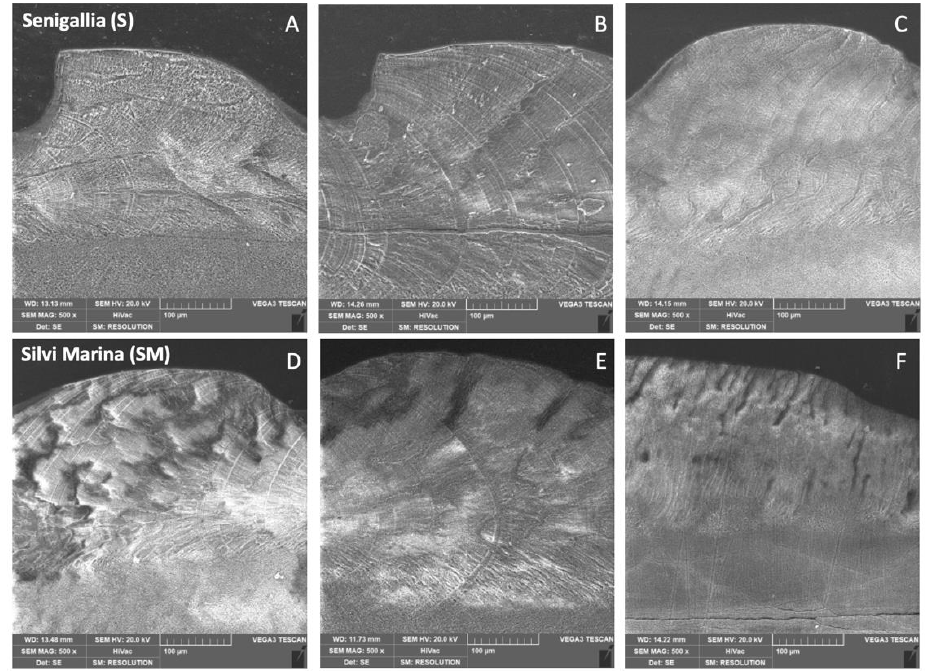
Figure 3. Scanning electron microscopy (SEM) observations obtained at 500× of magnification. ( A – C ) are referred to specimens of the Senigallia (S) sampling site. ( D – F ) are referred to specimens of the Silvi Marina (SM) sampling site.